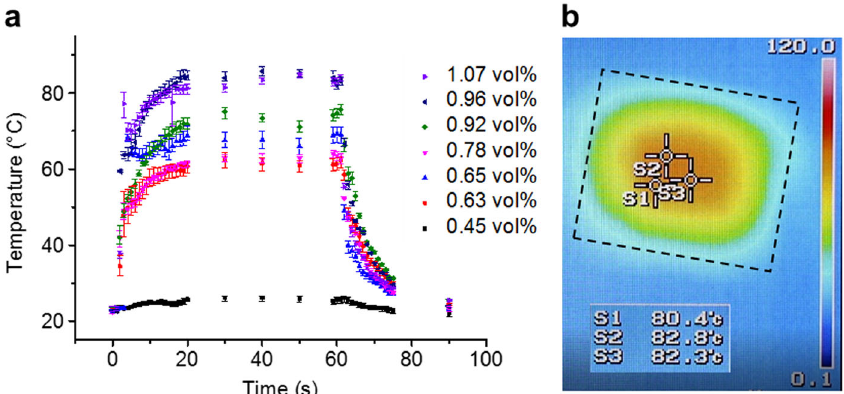
Fig. 3 Heating at constant voltage with increasing AgNW content. a Joule heating at 1.1 V for nonwovens with different AgNW contents. b IR camera image with an applied voltage of 1.1 V and 1.07 vol% AgNW nonwoven material (dotted lines). Scale unit: